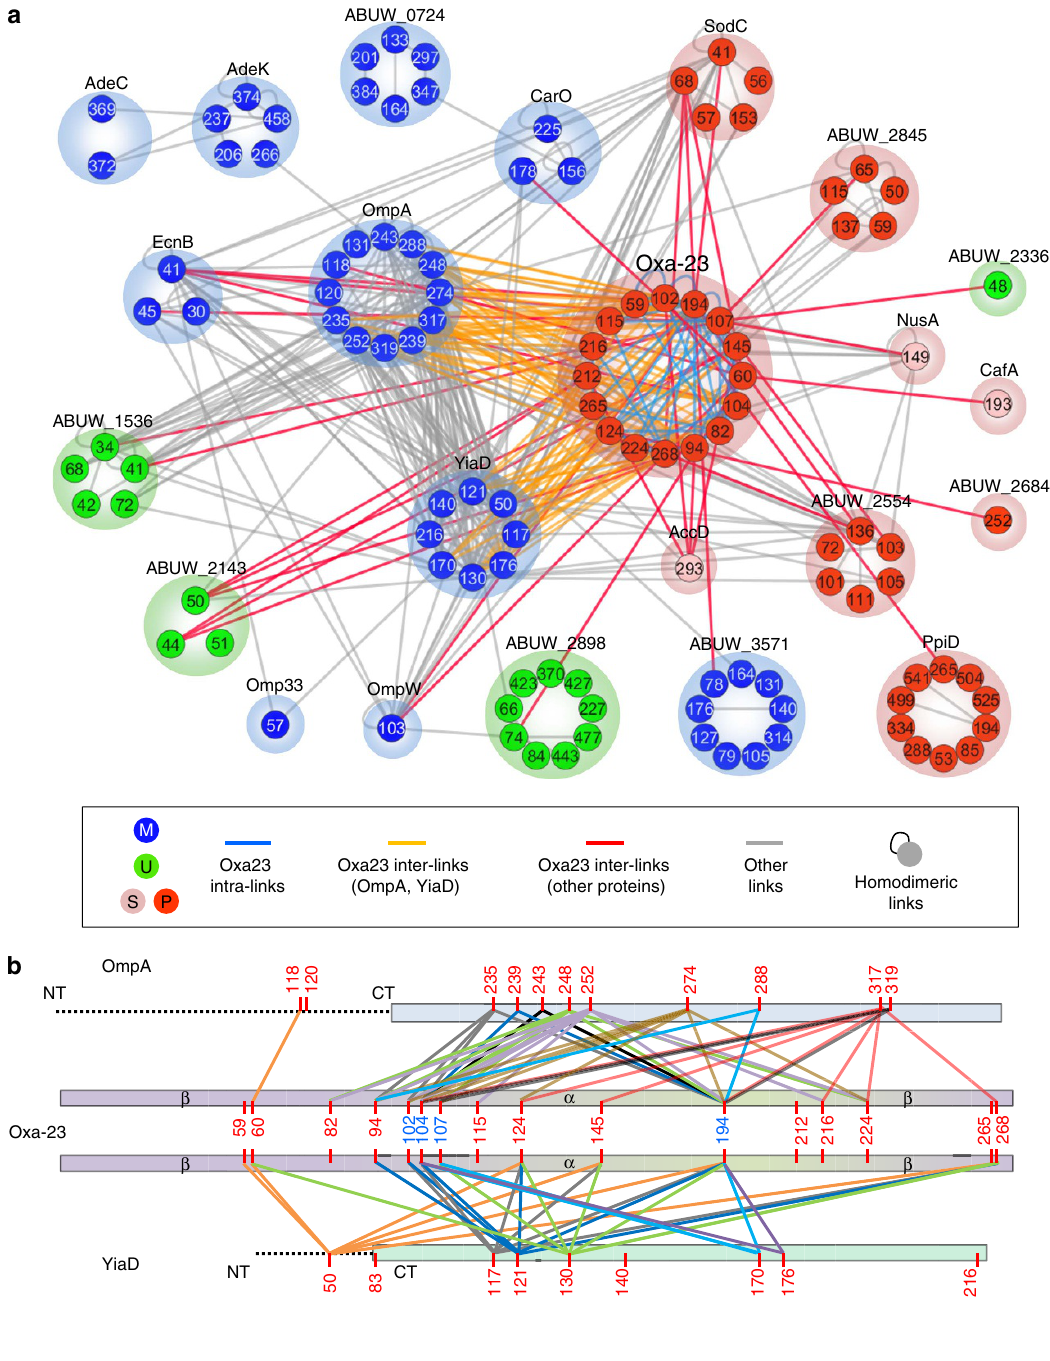
Figure 2 | Protein interaction network of Oxa-23 in AB5075. ( a ) The network included 18 Oxa-23 direct interaction partners (6 membrane, 4 uncharacterized and 8 soluble proteins) and four extended interaction partners (Omp33, AdeK, AdeC and ABUW_0724). Node number indicates cross-linked lysine residues. Nodes were grouped by proteins. Node colour shows the primary subcellular localization of the proteins. Blue, membrane proteins; green, uncharacterized proteins; light red, soluble proteins; dark red, soluble proteins predicted to localize in periplasm. Edge colours illustrate the specific types of Oxa-23 cross-links. Blue edges are intra-protein cross-links of Oxa-23. Orange or red edges are inter-protein cross-links of Oxa-23 to OmpA and YiaD, or to other interactors. Grey edges are cross-links formed between Oxa-23 interactors. The network was generated with Cytoscape 3.0.2 (ref. 73). ( b ) Inter-protein cross-links of OmpA-Oxa23 and YiaD-Oxa23 annotated with protein primary sequences and protein domains. Homodimeric cross-linked sites of Oxa-23 K102, K104, K107 and K194 are highlighted in blue. Cross-links are colored based on the cross-linked lysine residues of OmpA and